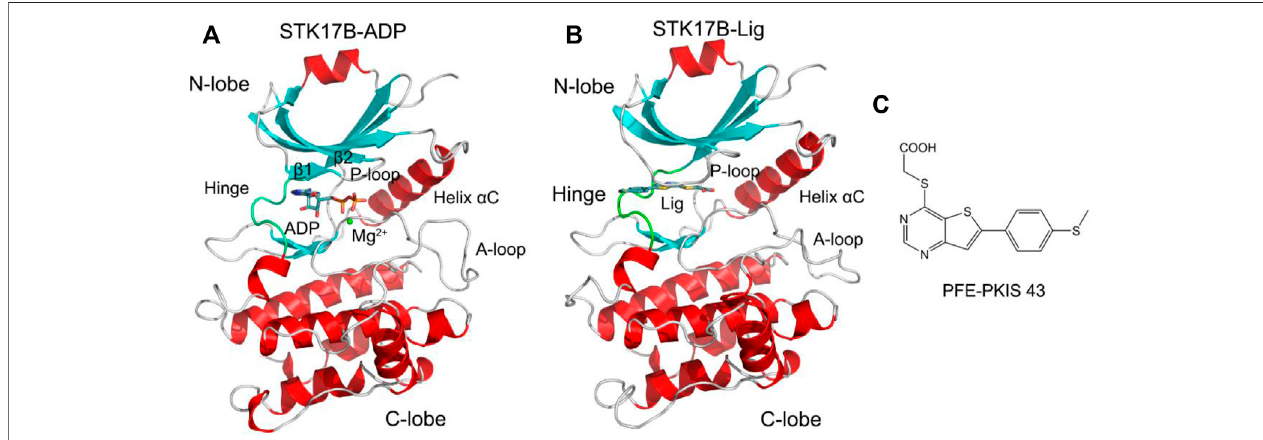
FIGURE 1 | Cartoon representation of STK17B in complex with ADP (PDB ID: 6QF4) (A) and the inhibitor PFE-PKIS 43 (PDB ID: 6Y6F) (B) . The secondary structural elements of α -helices and β -strands are colored by red and cyan, respectively. The loop including the phosphate-binding loop (P-loop) and the activation loop (A-loop) is colored by gray. The hinge domain is colored by green. ADP and inhibitor are depicted by stick representation. Mg 2+ ion is shown by a green sphere. (C) Chemical structure of the inhibitor PFE-PKIS